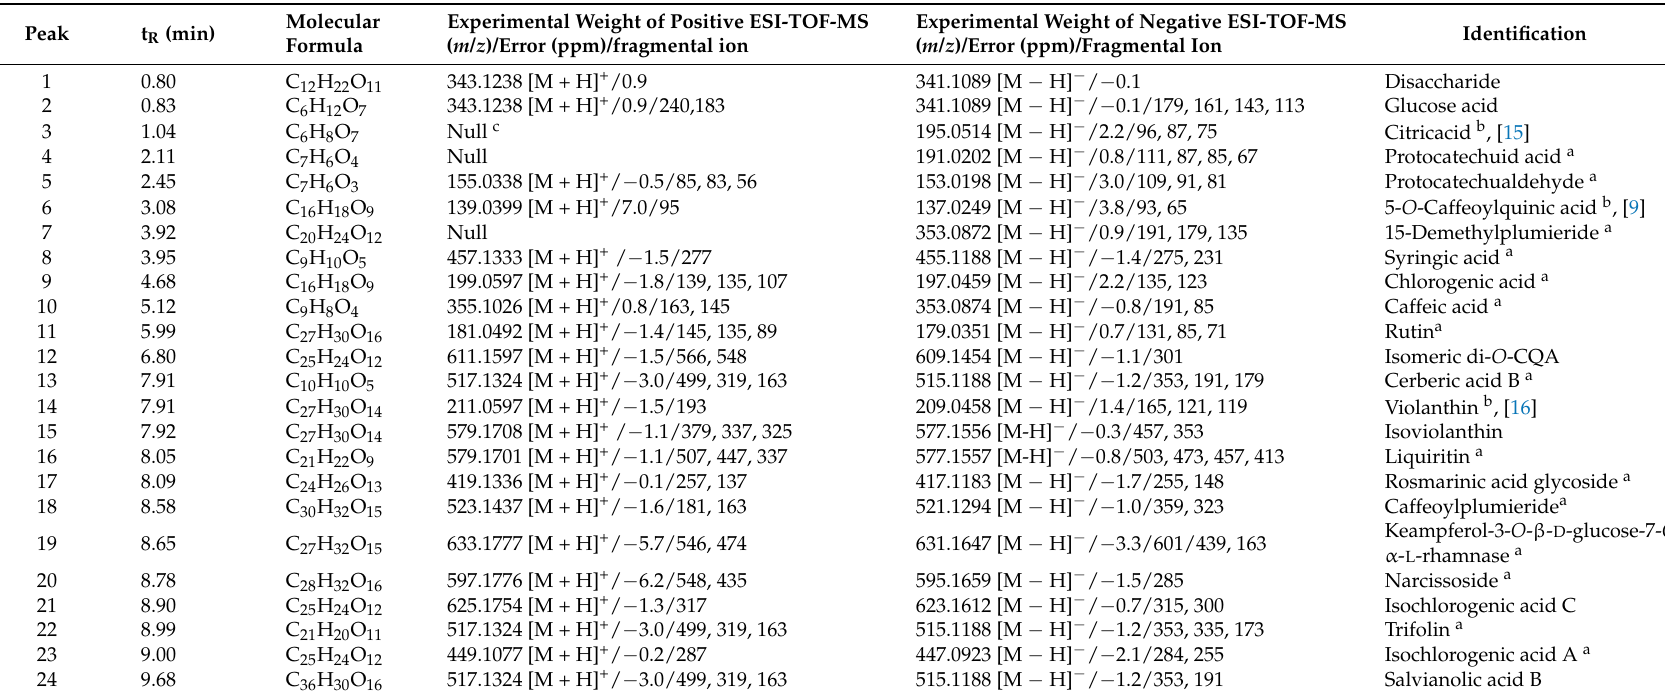
Table 1. Identification of chemical constituents of WLJ herbal tea by UPLC/Q-TOF-MS/MS in positive and negative ion modes. Peak t R